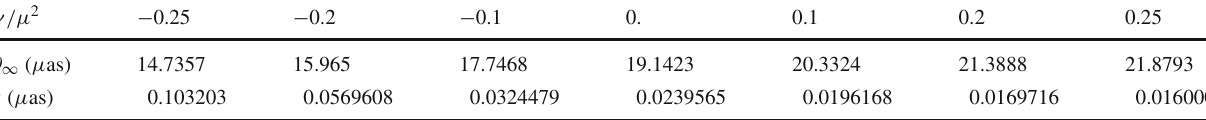
Fig. 4 Limiting location of the images θ ∞ (left) and angular separation s between the first image and the limiting value (right), as functions of γ/μ 2 for the supermassive black hole in M87 Table 3 Numerical values of the observables θ ∞ and s for various values of γ/μ 2 for the supermassive black hole in